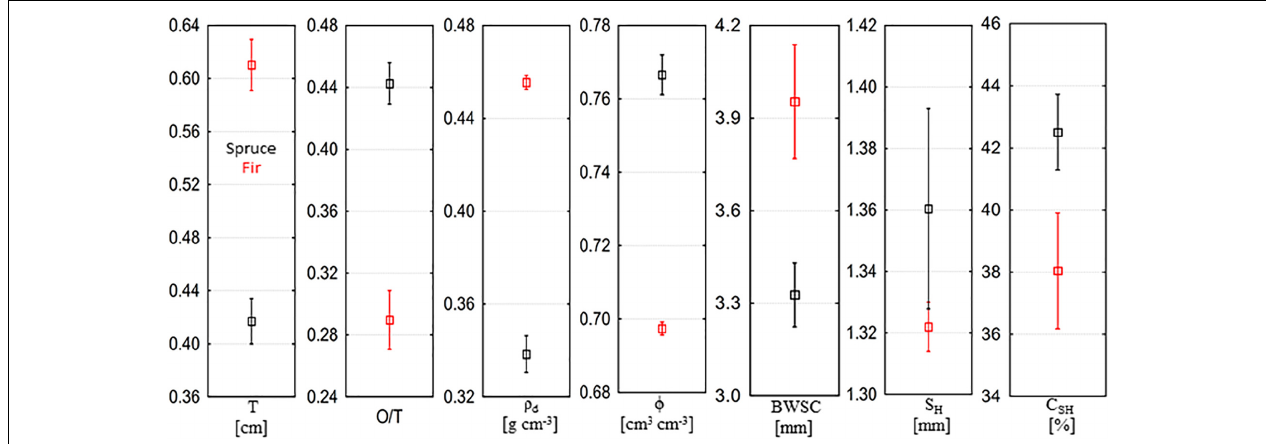
FIGURE 2 | Physical and hydrological properties of Norway spruce and silver fir bark, where T is the thickness of total bark, O/T is the outer to total bark thickness ratio, ρ d is the bulk density, φ is the total porosity, BWSC is the bark water storage capacity, S H is the bark hygroscopicity, and C SH is the proportion of bark water storage capacity occupied by bark hygroscopicity (mean ±